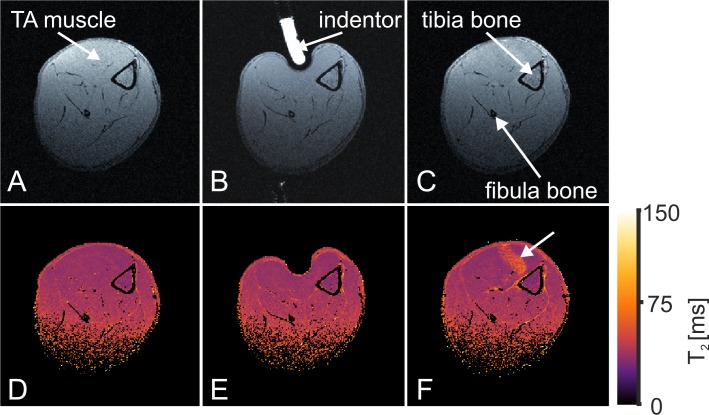
Anatomical images and T2 maps.Axial anatomical images (A-C) and T2 maps (D-F) of the hind limb before, during, and after indentation, respectively.